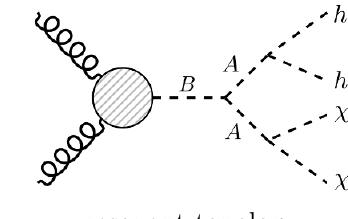
Figure 1 . Topologies for a scalar s -channel resonance B decaying into di-Higgs plus =E of scalars AA . If A decays via A ! h(cid:31) , then the symmetric topology shown on the left emerges. The decays A ! hh and A ! (cid:31)(cid:31) , on the other hand, lead to the resonant topology on the